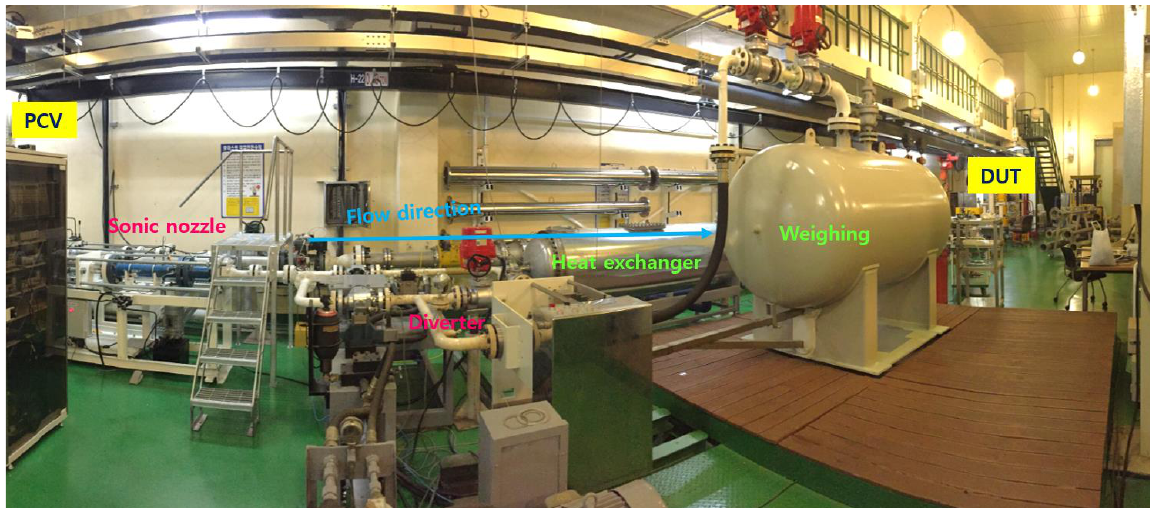
Figure 3. High-Pressure Gas Flow Standard System of KRISS.